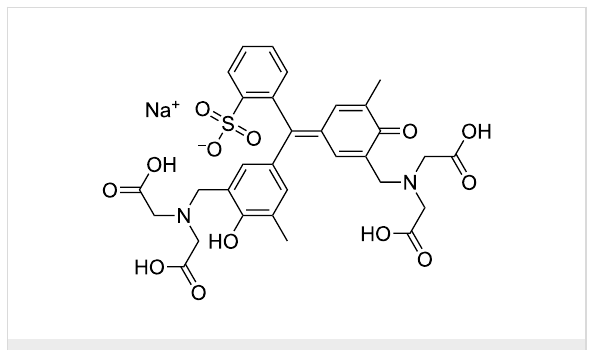
Figure 1: Structure of xylenol